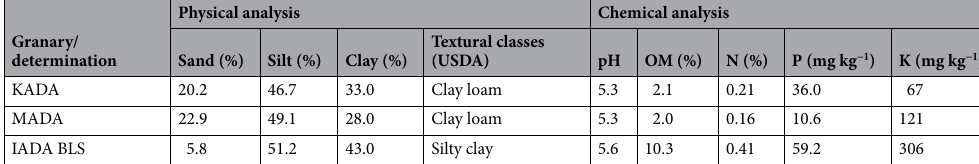
Table 1. Physico-chemical properties of the soil used for each field trial. MADA: Muda Agricultural Development Authority, KADA: Kemubu Agricultural Development Authority, IADA BLS: Integrated Agriculture Development Area Barat Laut Selangor, OM: Organic matter, N: Total nitrogen, P: Available phosphorus and K: Available potassium.